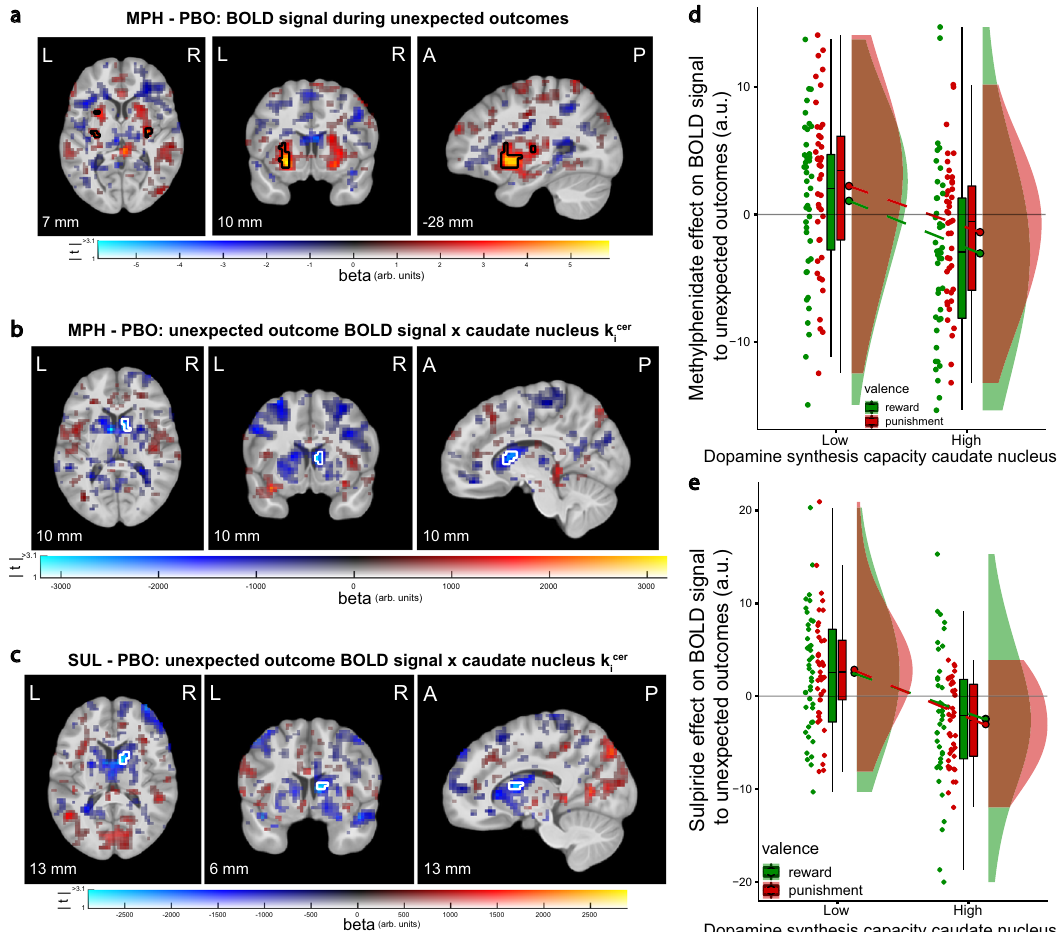
Fig.2|Effectsofmethylphenidateandsulpiride(relativetoplacebo)onstriatal BOLD signal to unexpected outcomes. a Methylphenidate increased reversal- related striatal signals. Results of univariate regression analysis showing the effect of methylphenidate on BOLD signal related to unexpected outcomes (MPH −